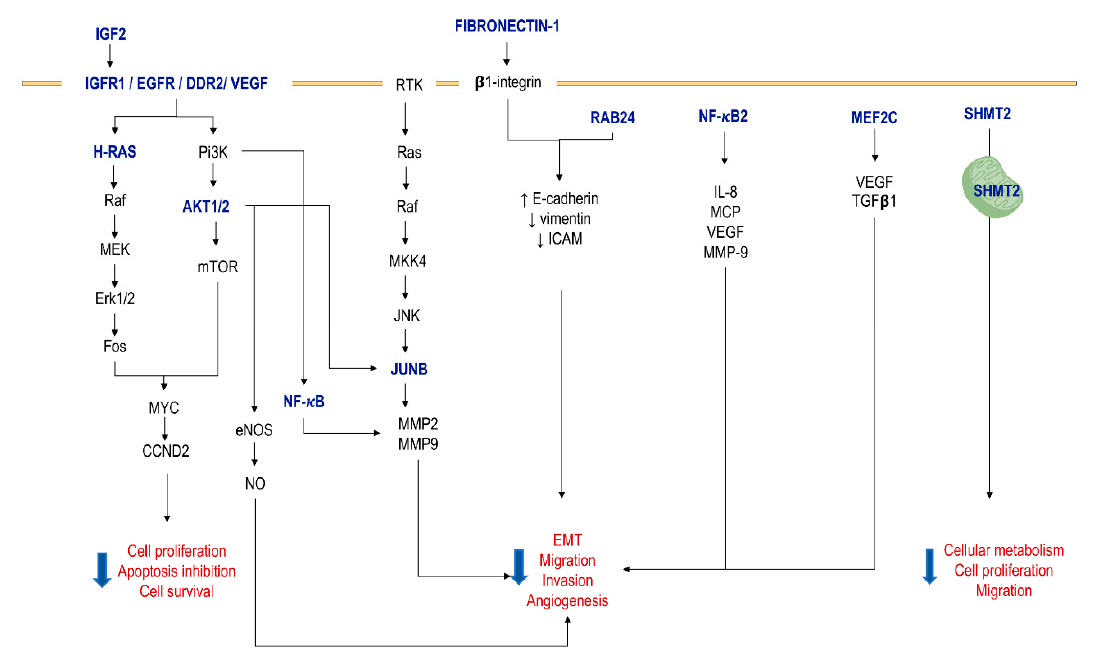
Figure 2. Schematic representation of the effects of miR-615-5p on cancer. The molecules that are a direct target of miR-615-5p are indicated in blue. The signaling pathways that are inhibited by the increase in miR-615-5p concentration are schematized, as well as the functional consequences that this implies, which together generate a clear tumor suppressor effect. See the text for further explanation.